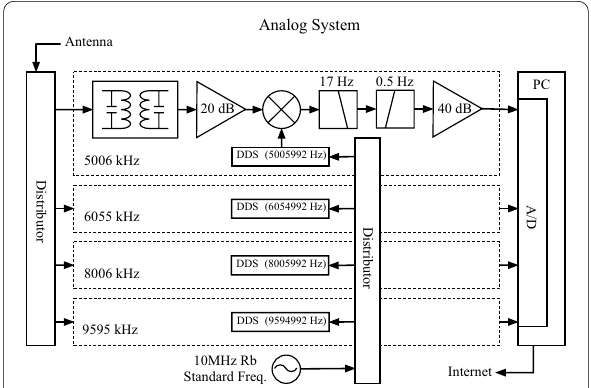
Fig. 2 Block diagram of the conventional analog receiving